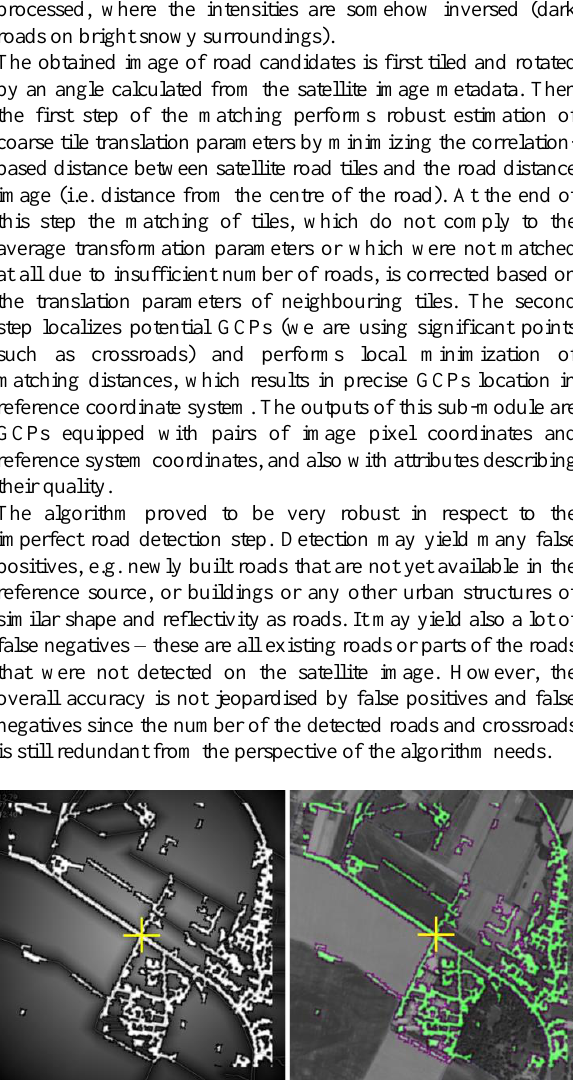
Figure 4. An example of a GCP matched onto the road distance image. On the left figure dark shades of gray are distances from reference roads; whites are features (possibly roads) extracted from satellite image; yellow cross is the GCP position. On the right figure the same set of features extracted from satellite image (coloured green) is placed over the aerial orthophoto.